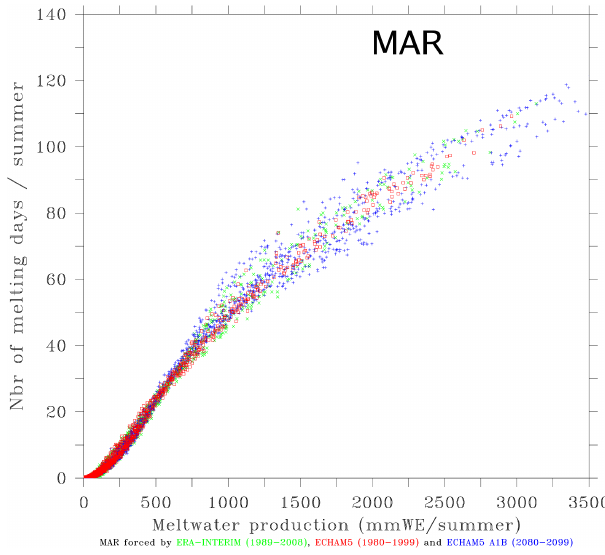
Fig. 12. Scatter plot of the mean number of melt days versus the mean annual meltwater production (in mmw.e.yr − 1 ), for each grid box and for each year of simulation, for MAR forced by ERA- Interim over 1989–2008, ECHAM5 (recent past) over 1980–1999 and ECHAM5-A1B over